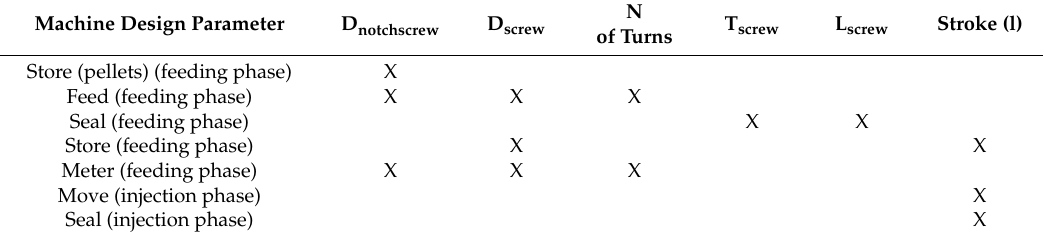
Table 8. Axiomatic matrix for the IM machine.